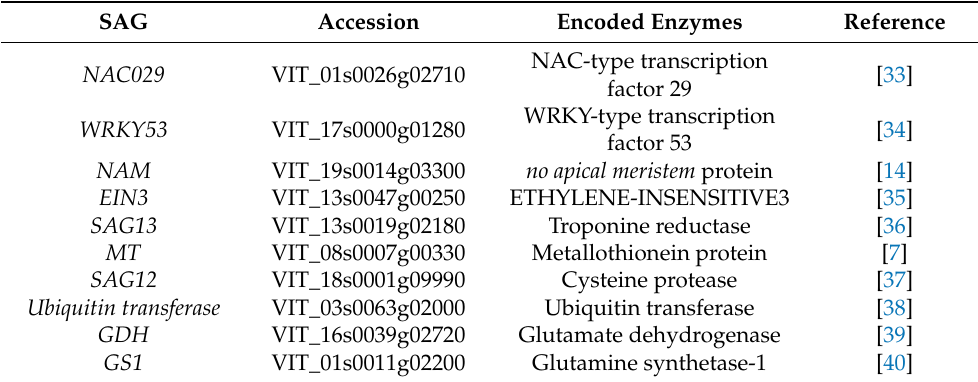
Table 1. Overview of examined senescence-associated genes (SAGs) within the gene transcription analysis of Vitis vinifera cv. Riesling leaves.